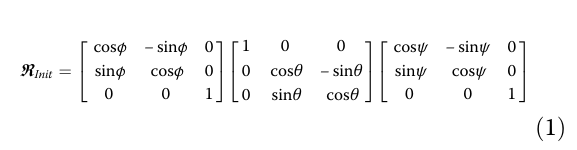
The rotation unit vector in the reference coordinate system is: